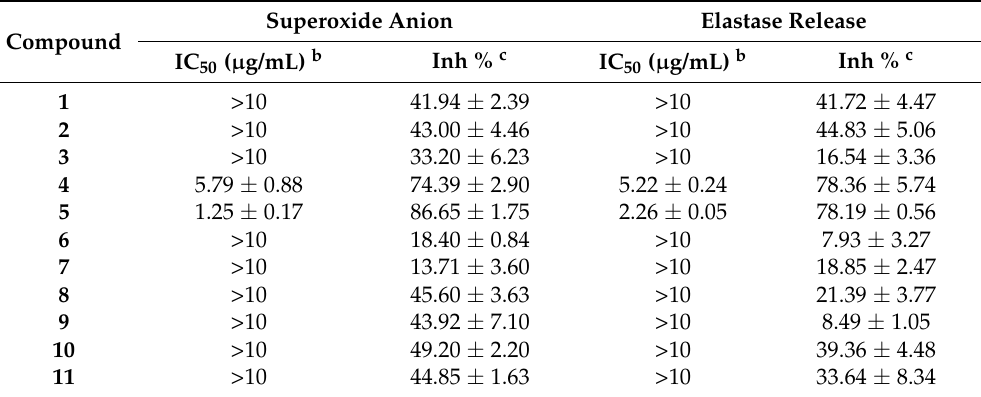
Table 4. Anti-inflammatory data of compounds 1 – 11 a